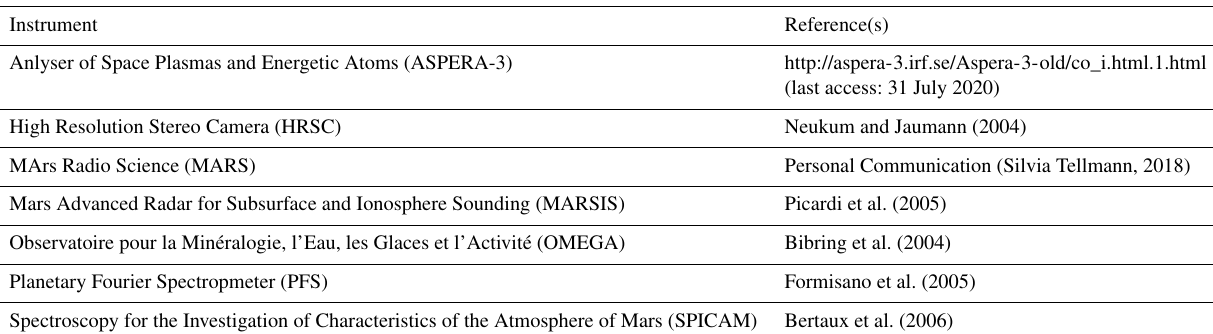
Table A6. Mars Express’s instruments and references for team members